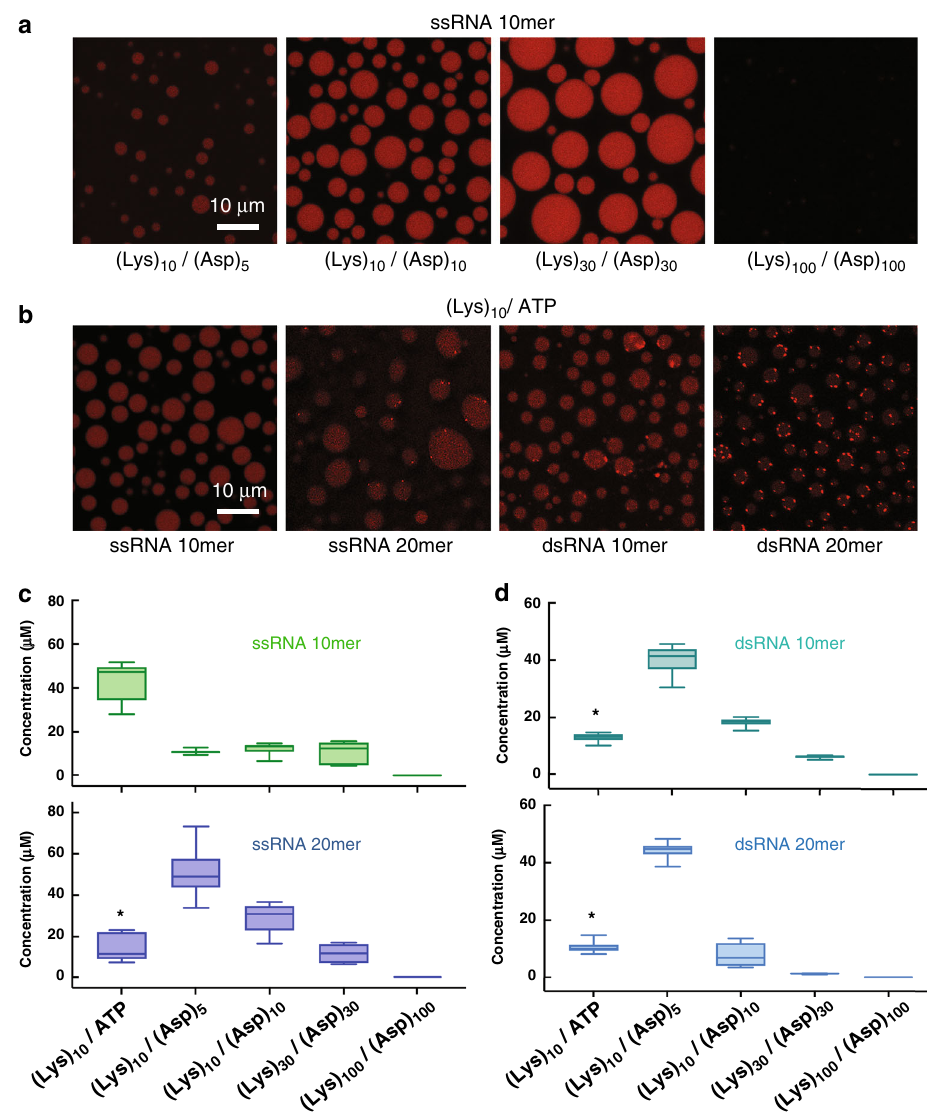
Fig. 4 Partitioning of ss and dsRNA 10- and 20mers in selected coacervates. a Fluorescence images of Cy3-labeled ssRNA 10mer in (Lys) 10 /(Asp) 5 , (Lys) 10 /(Asp) 10 , (Lys) 30 /(Asp) 30 , and (Lys) 100 /(Asp) 100 coacervate systems. b Fluorescence images of Cy3-labeled ssRNA 10mer and 20mer, and dsRNA 10mer and 20mer all in a (Lys) 10 /ATP coacervate. Note that laser intensity was optimized separately for each sample in panels a and b ; quanti fi cation based on calibration curves is shown in panel c and d . c , d Calculated concentration of ssRNA 10mer and 20mer, and dsRNA 10mer and 20mer in the coacervate droplets for (Lys) 10 /ATP, (Lys) 10 /(Asp) 5 , (Lys) 10/ (Asp) 10 , (Lys) 30 /(Asp) 30 , and (Lys) 100 /(Asp) 100 coacervate pairs. Center lines show the medians; box limits indicate the 25th and 75th percentiles; whiskers extend maximum and minimum data points. Note that bright puncta were observed for (Lys) 10 /ATP for partitioning of ssRNA 20mer and of dsRNA 10mer and 20mer. Asterisks represent the coacervates containing puncta/speckles. RNA strands were added to a fi nal concentration of 0.1 µ M for all cases. RNA concentration in the droplets was calculated without including ATP/(Lys) 10 bright speckles, which we interpret as a new phase in which RNA is the main polyanionic component. Error bars show standard deviation of measurements of average of 20 samples over analysis of three independent